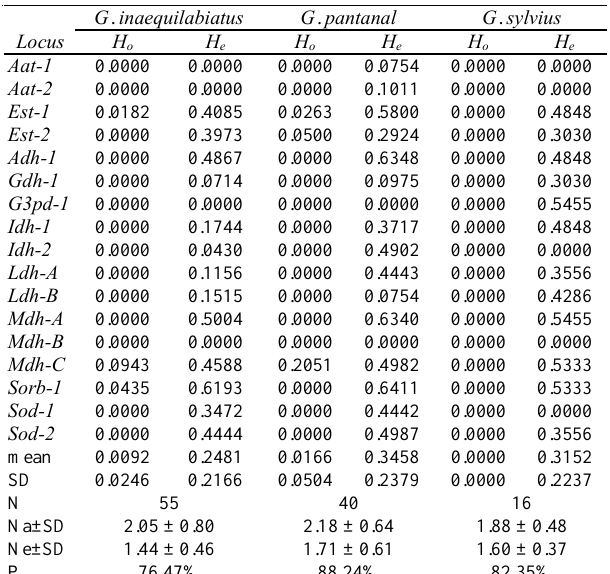
Table 4. Chi-square test for homogeneity of allele frequencies Table 3. Genetic variability estimates for each locus of the for G . inaequilabiatus , G . pantanal and G . sylvius from Caracu Gymnotus species from Caracu stream, Paraná State, Brazil. = observed heterozygosity; H = unbiased expected stream, Paraná State, Brazil. Bold type indicates the loci which H o e heterozygosity; SD = standard deviation; N = number of were statistically different. χ 2 = chi-square value; DF = degree specimens; Na = mean number of alleles per locus ; Ne = of freedom. effective number of alleles per locus ; P = proportion of polymorphic loci .